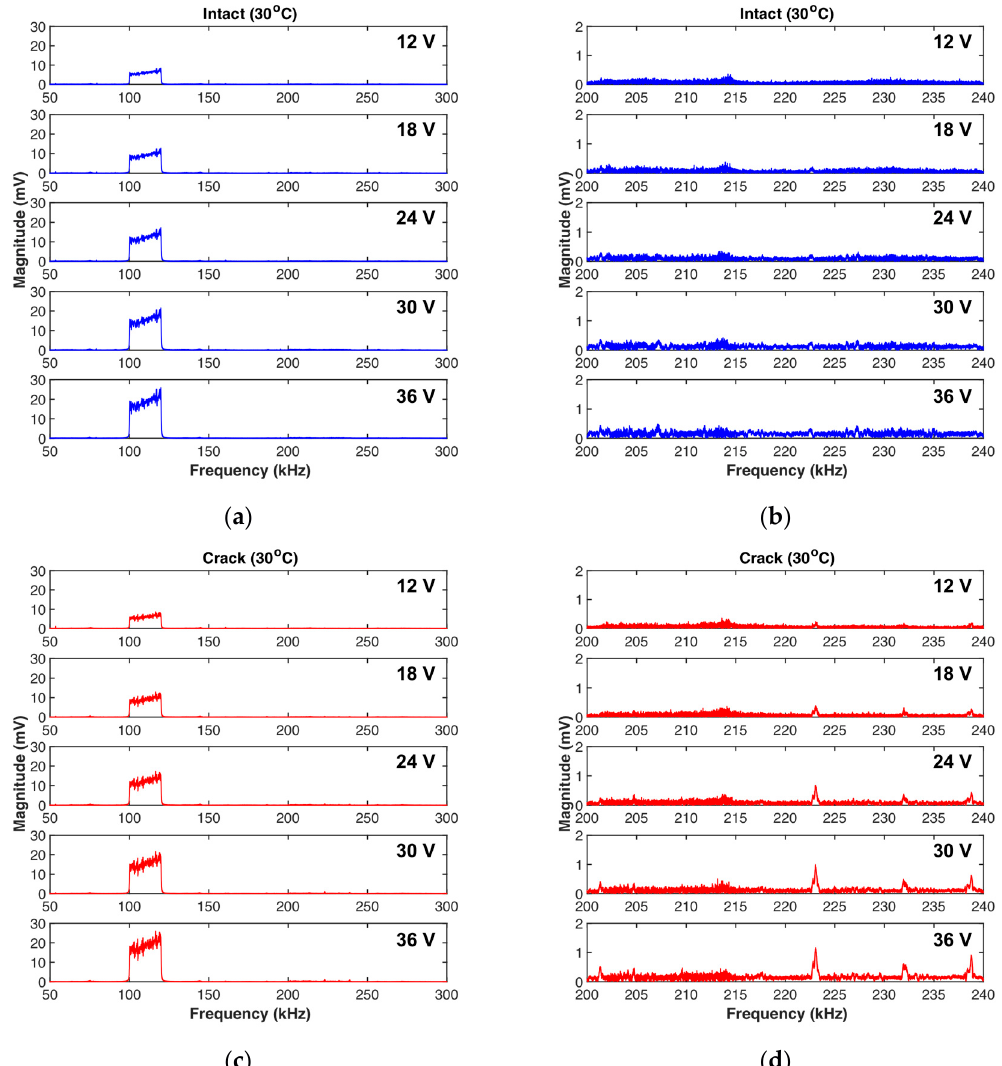
Figure 9. Representative test results in the frequency domain: ( a ) Primary and ( b ) 2nd harmonic responses of the intact case, and ( c ) primary and ( b ) 2nd harmonic responses of the cracked case at 30 °C.